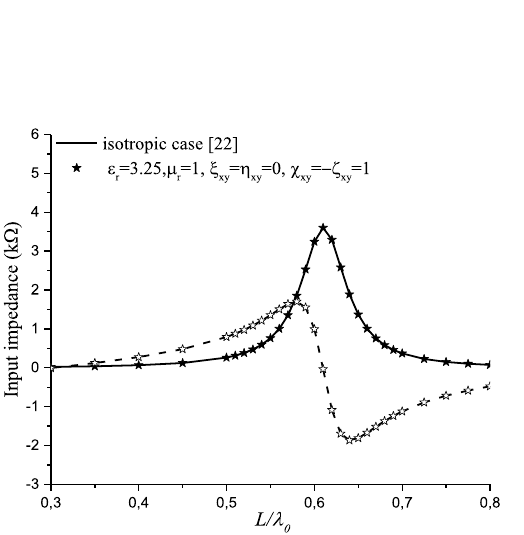
ς xy ) on the input = −